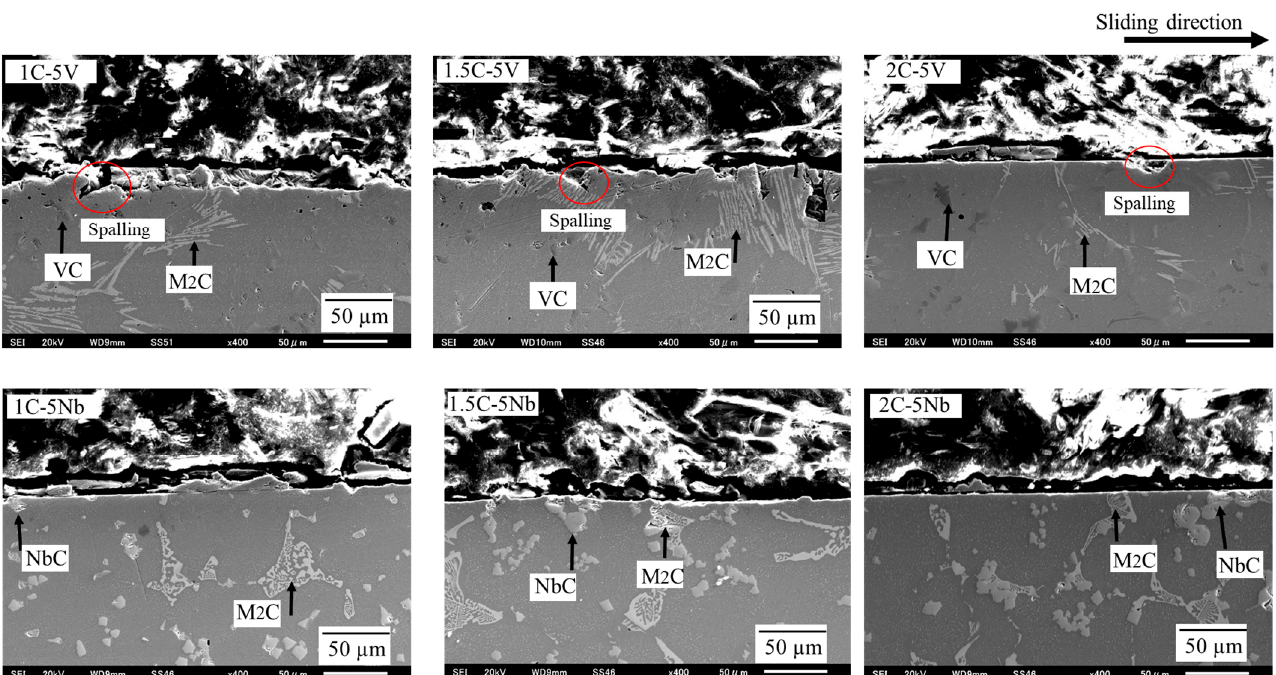
Figure 11. Investigation of abrasive wear mechanisms through worn surfaces using SEM.